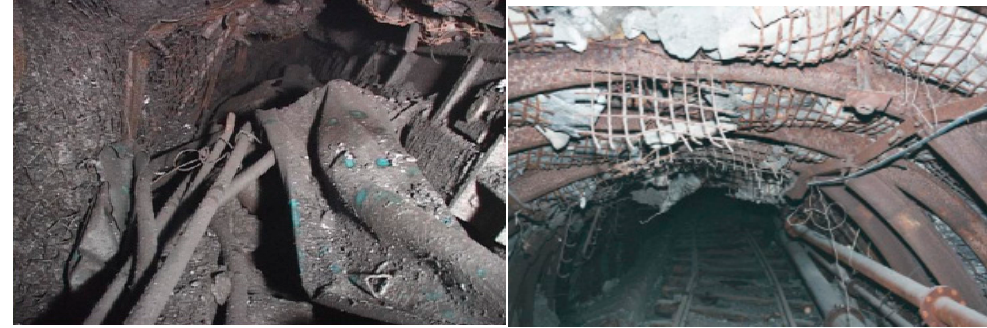
Figure 1. Field photos after severe roadway damage.